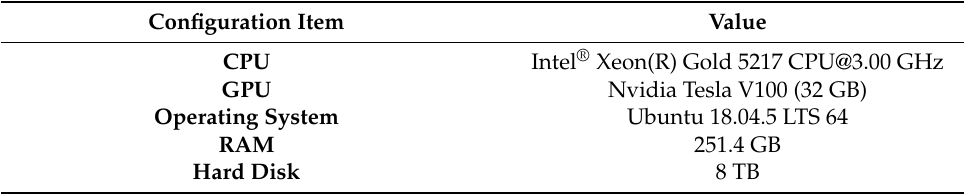
Table 4. Hardware and software